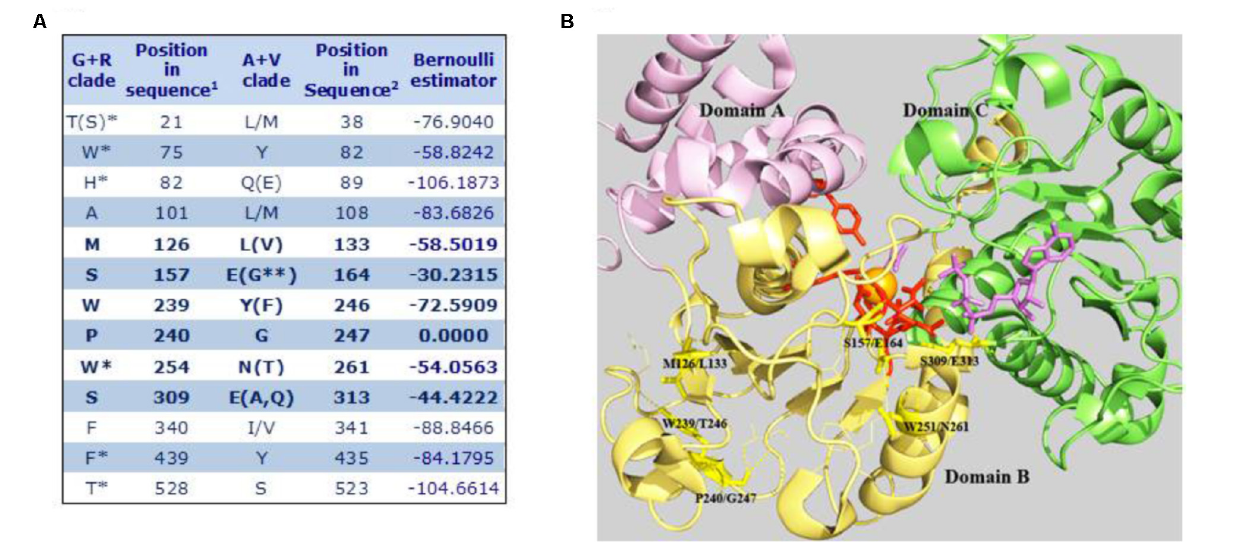
Frontiers in Plant Science |